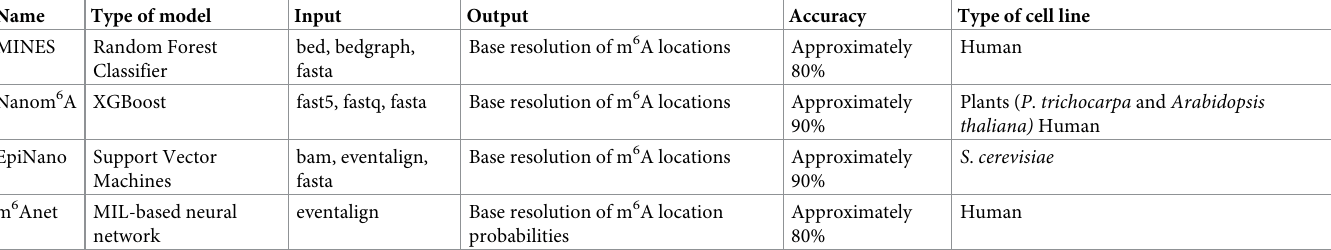
Table 1. Bioinformatics tools for m 6 A detection based on nanopore sequencing